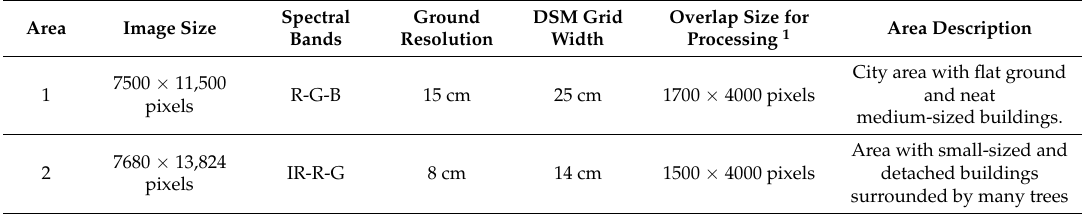
Table 1. Description of two data. DSM: digital surface model.